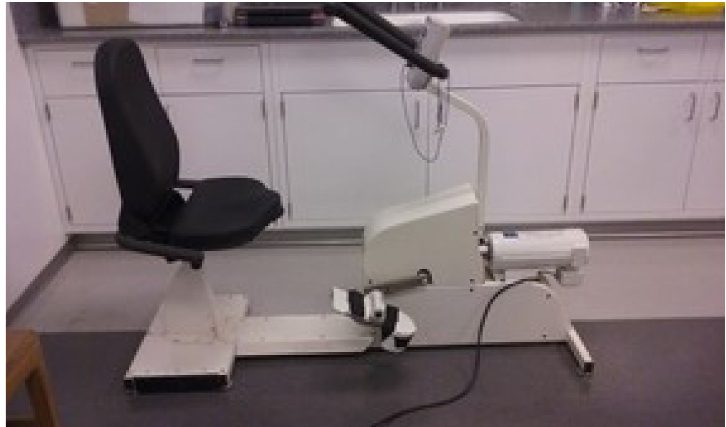
Figure 1. Experimental set up for assisted cycle Therapy